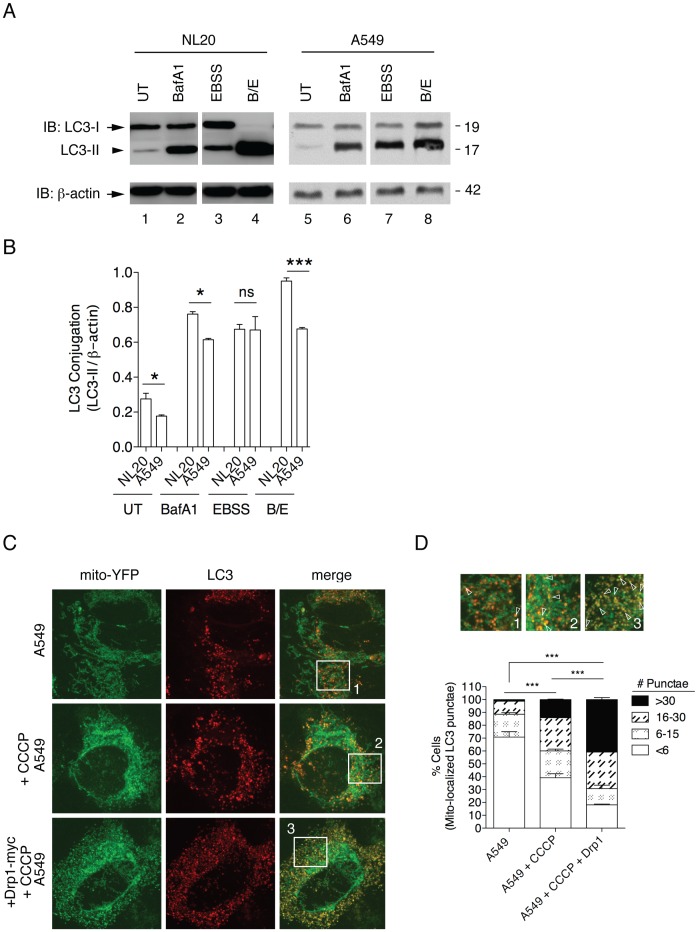
Impaired turnover of mitochondria prior to degradation by the lysosome.(A) Representative immunoblot of LC3-I (arrow) to LC3-II (arrowhead) conversion in total protein from untreated (UT; lanes 1,5), 10 nM 24 h Bafilomycin A1 treated (BafA1; lanes 2,6) 24 h serum starved (EBSS; lanes 3,7) or combined 24 h BafA1/EBSS treated (B/E; lanes 4,8) NL20 and A549 cells. β-actin reprobe to show loading. (B) LC3-II quantification (normalized to β-actin) from two independent experiments. Cells conditions were as in (A) to examine differences between (B) cell lines. Mean and SEM shown, 2-way ANOVA analysis with Bonferroni post-test. (C) Mito-YFP transfection (left) and LC3 immunostaining (middle) in A549 cells show mitophagy by colocalization of LC3 with the mitochondria (merged, right). A549 cells treated with 10 µM CCCP for 30 minutes (middle) or transfected with Drp1-myc for 24 h and CCCP treated (bottom). Representative images of mitophagy by colocalization of mito-YFP and LC3 punctae (yellow expression) in CCCP and CCCP/Drp1-myc conditioned A549 cells. Scale bar is 2 µm. (D) Quantification of mitophagy as in (C). Box insets show enlarged microscopy sections to illustrate a selection of mitophagy events occurring (white open arrowheads) which are labeled 1–3 corresponding to original images as shown in (E); A549 (1), A549+CCCP (2), and A549+CCCP/Drp1-myc (3). Percent cell counts (>200) from three independent experiments were based on colocalization of LC3 punctae staining with mito-YFP (values represent mean number of punctae counts per cell binned with SEM). 2-way ANOVA analysis with Bonferroni post-tests.